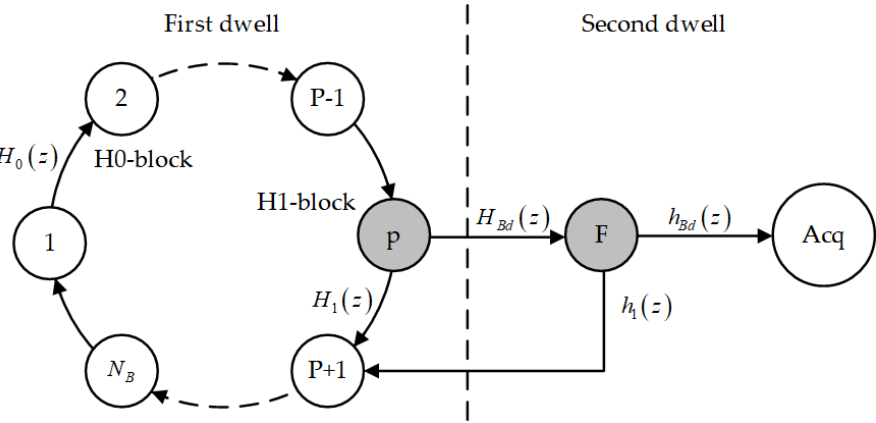
Figure 8. Flowchart of search procedure.